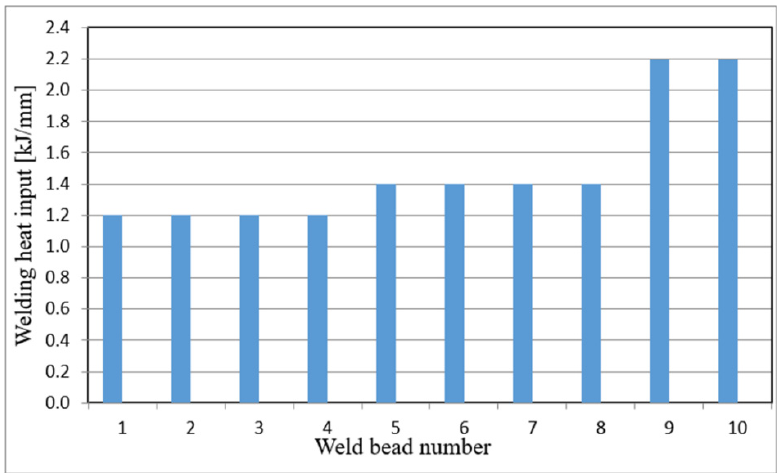
Figure 1. Distribution of heat input in individual beads of the welded joint.